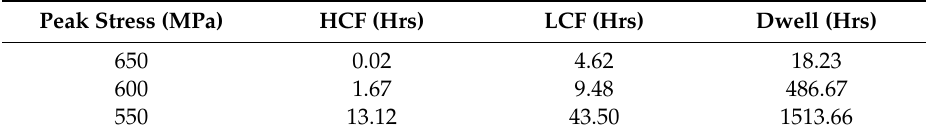
Table 2. Time at maximum stress under di ff erent waveform